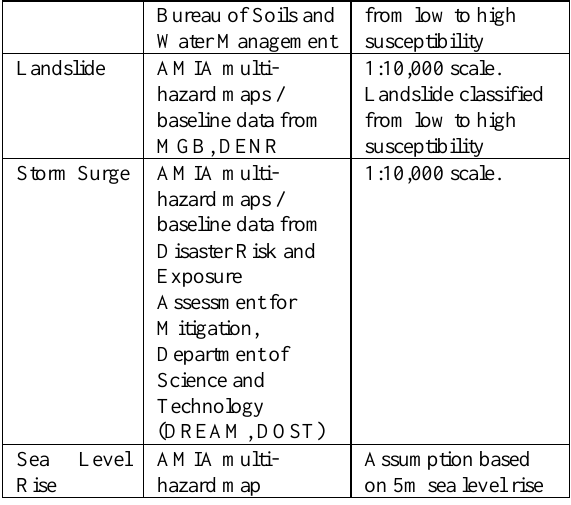
Table 3. Hazards datasets used for exposure component.